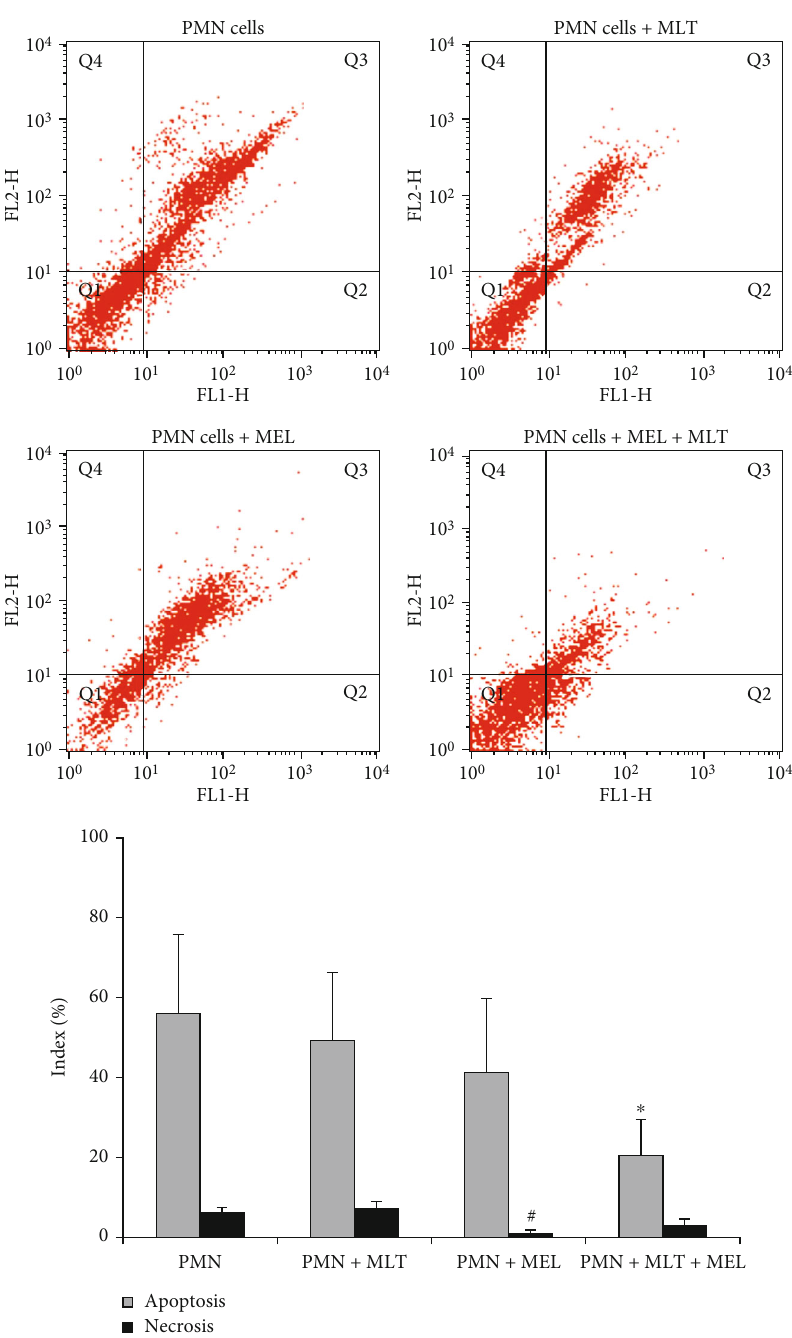
Figure 3: Apoptosis and necrosis in colostrum PMN cells. PMN: polymorphonuclear cells; MLT: melatonin; MEL: microemulsion after 72 hours of incubation. Cells were stained with Annexin V/PI and analyzed by fl ow cytometry. In the dot plot, the lower-left (Q1) quadrant corresponds to a viable cell; the lower-right (Q2) and upper-right (Q3) quadrants represent the percentage of apoptosis, and the upper- left (Q4) quadrant is the percentage of necrosis. p < 0 : 05 . ∗ Compared to apoptosis index of PMNs untreated with PMNs treated; # compared to necrosis index of PMNs treated with